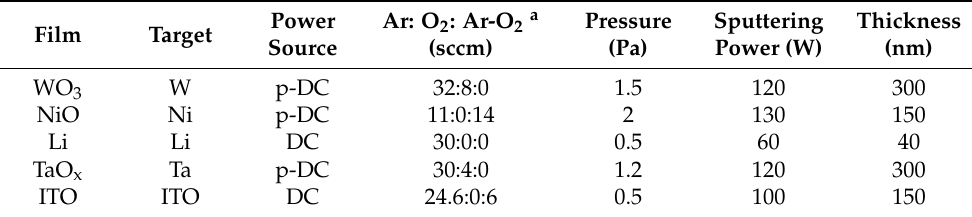
Table 1. Deposition parameters for the WO 3 , NiO, Li, TaO x , and top ITO layers of all-solid-state ECD.